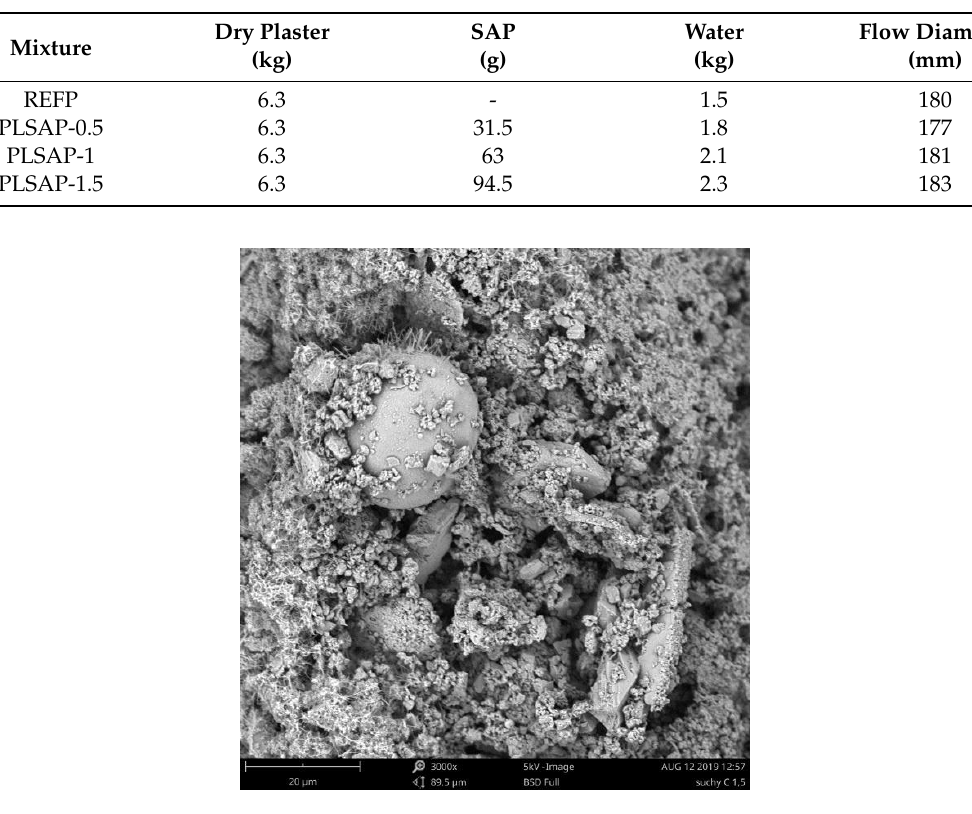
Figure 1. Scanning Electron Microscopy (SEM) image of dried PLSAP-1.5.